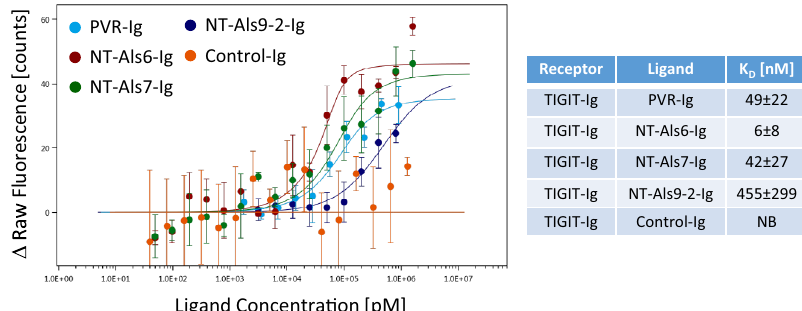
Fig. 4 Puri fi ed Als fusion proteins are direct TIGIT ligands. A microscale Thermophoresis experiment analyzing the interactions between fl uorescently labeled TIGIT-Ig and either PVR-Ig (teal), NT-Als6-Ig (red), NT-Als7-Ig (green), NT-Als9-2-Ig (dark blue) or a negative control protein fused to an Ig tag (Control-Ig, orange). Shown are a graph and a summary table. n = 2 – 4 replicates derived from two biologically independent experiments. Error bars represent the standard error of the mean. NB =